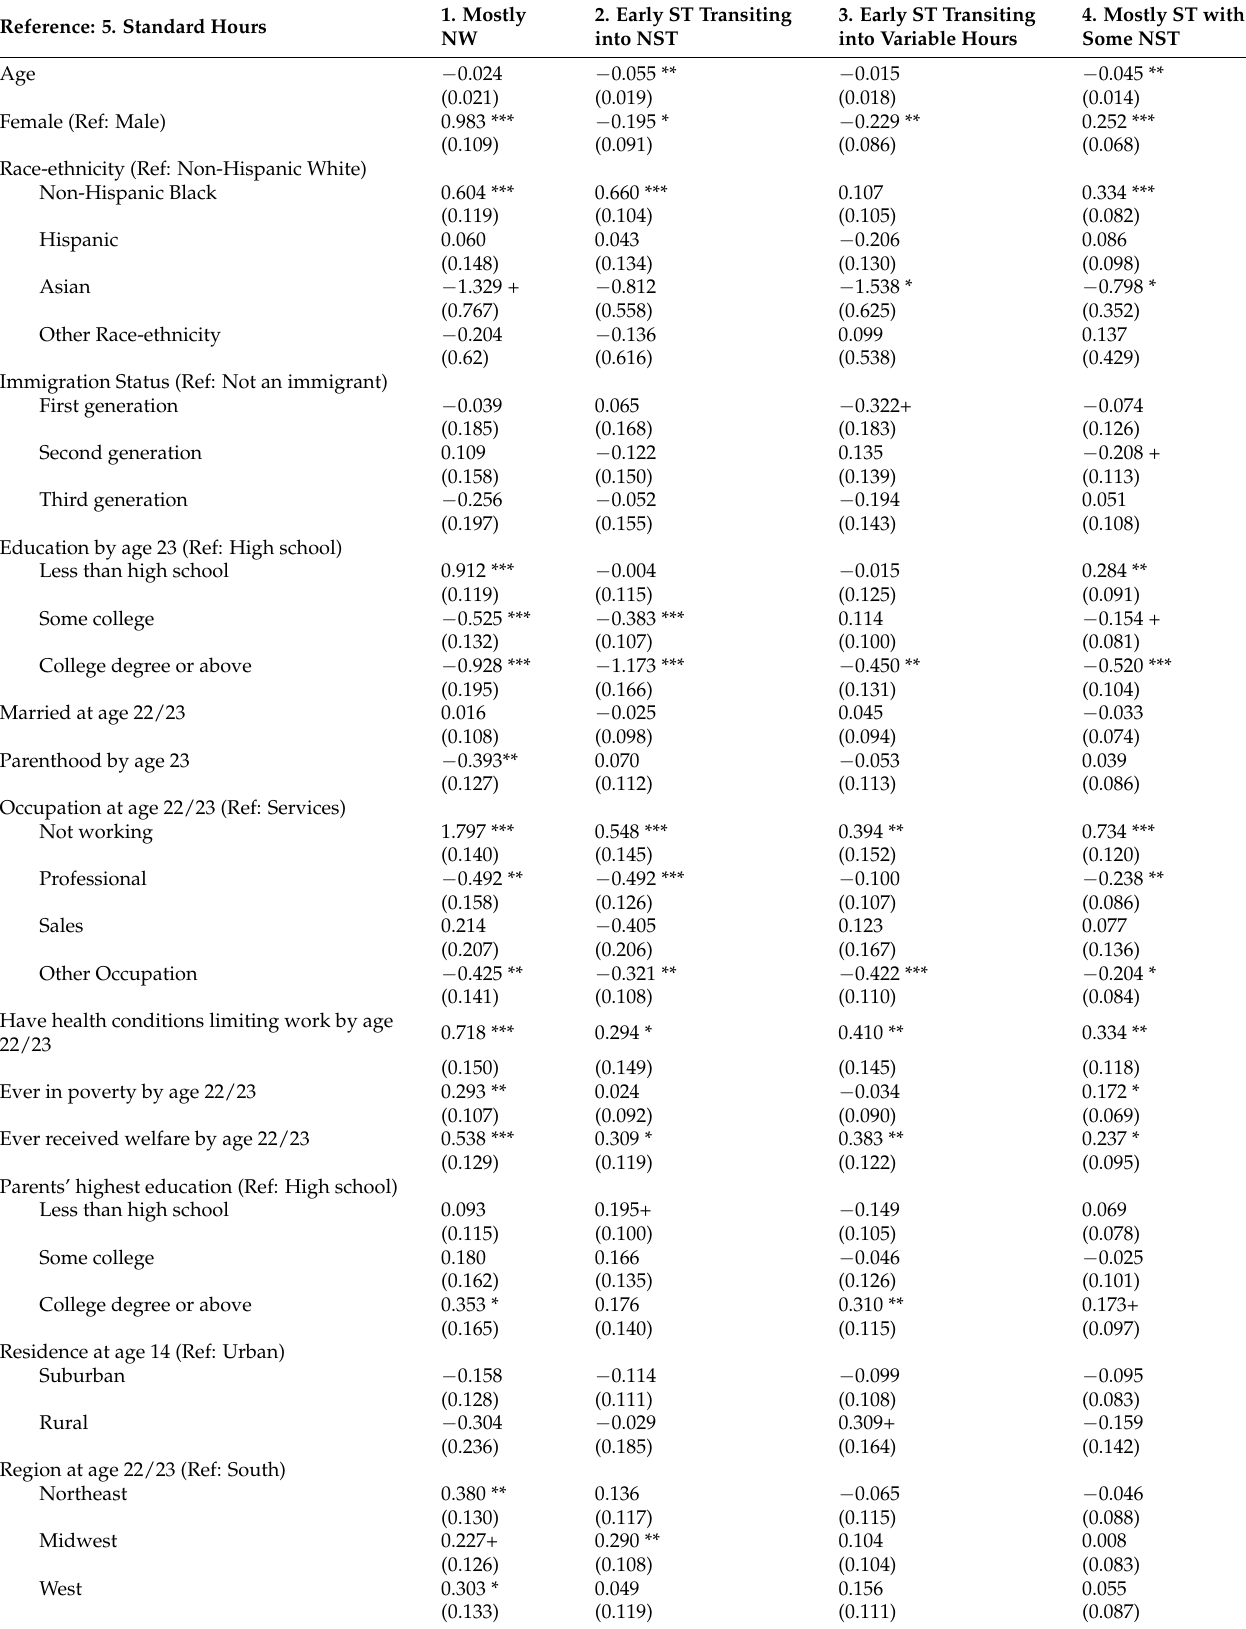
Table 2. Multinomial Regression Estimates of Work Patterns (N =